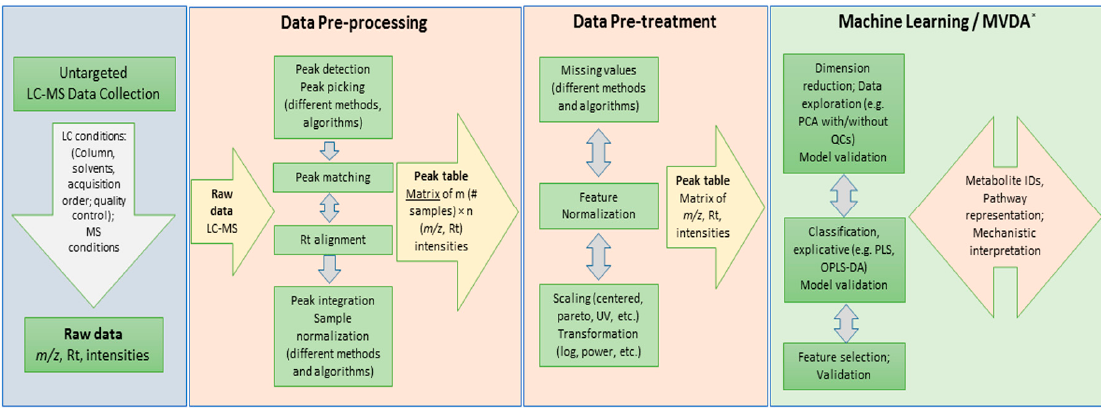
Figure 6. Flowchart displaying an overview of a typical LC-MS data mining pipeline. Different